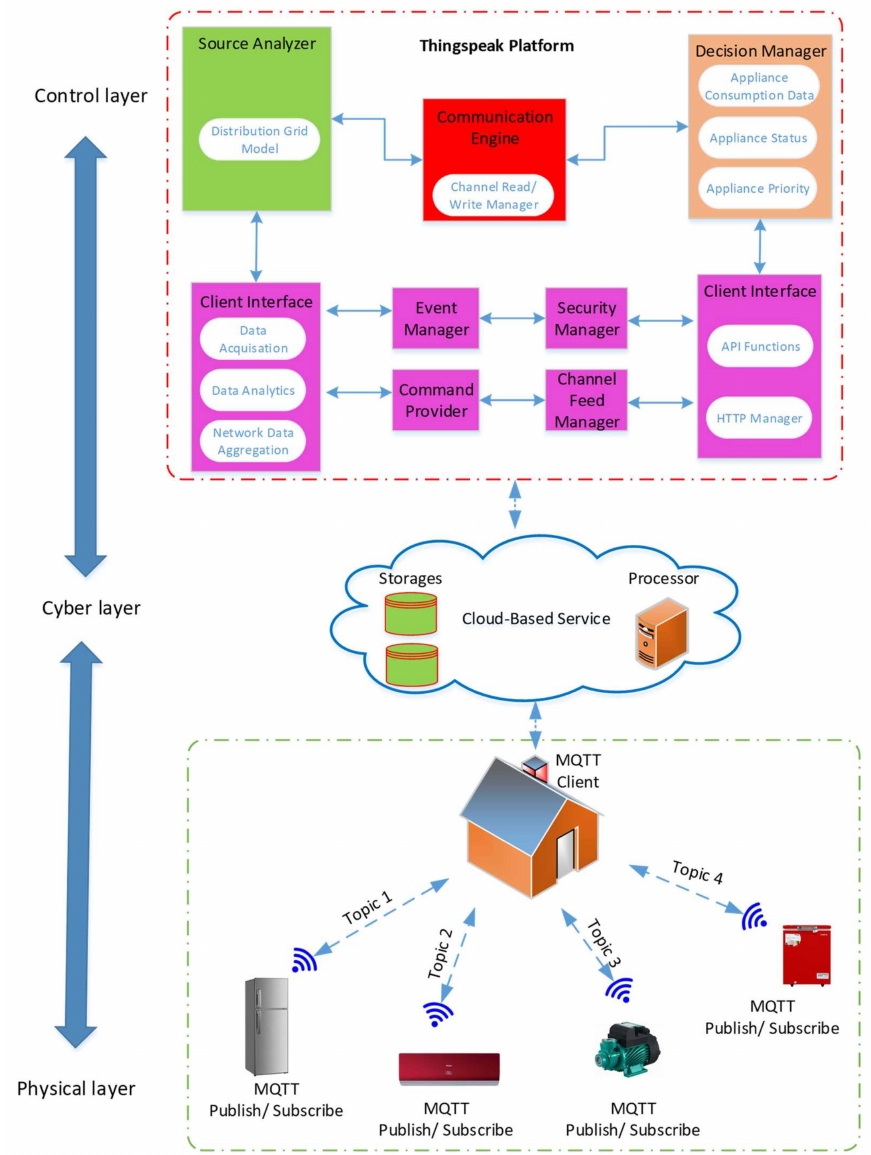
Figure 5. Smart home proposed architecture of communication.3.4. Proposed Optimization